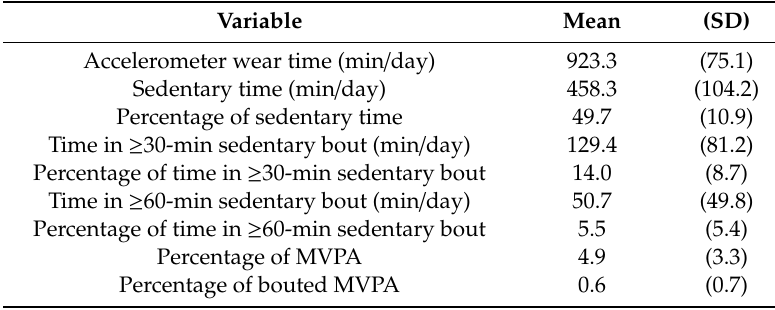
Table 2. Patterns of sedentary time and moderate-to-vigorous physical activity (MVPA) of women with fibromyalgia, n =